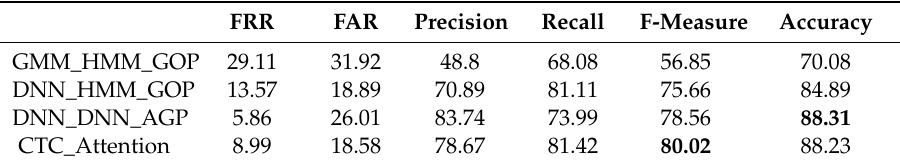
Table 12. Performance of APED systems for final ang. FAR